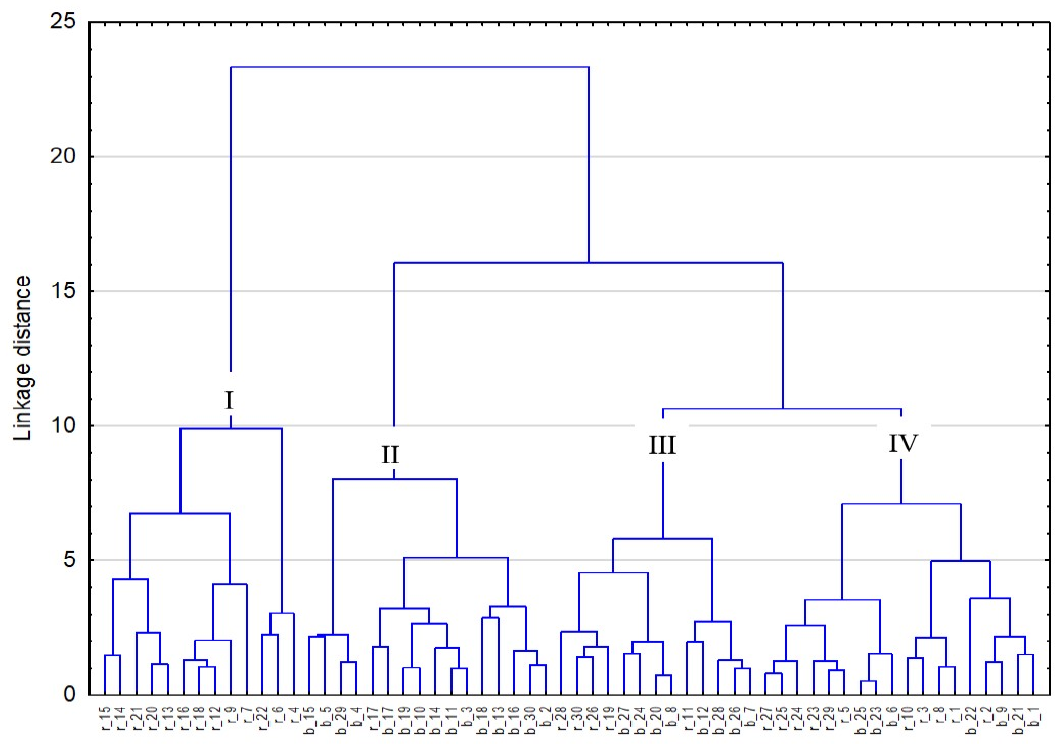
Figure 2. Dendrogram showing the results of the hierarchical cluster analysis (r—regular diet, b—bland diet, 1—Bia ł a Podlaska, 2—Che ł m, 3—Zamo ść , 4—Rzeszów, 5—D ę bica, 6—Przemy ś l,